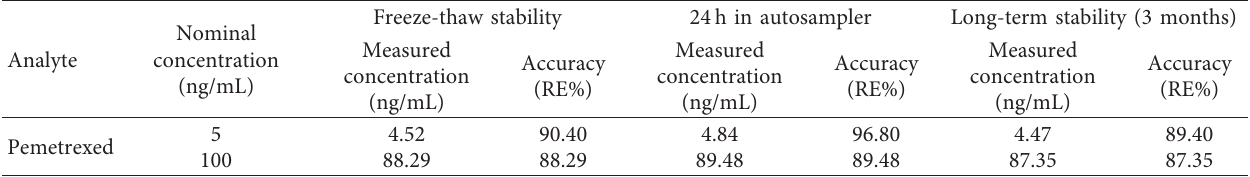
Table 5: Results of stability investigation of pemetrexed ( n � 6).